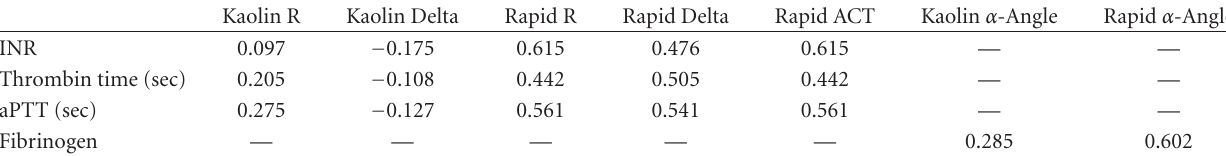
Table 4: Correlation of TEG Measurements versus INR, TT, and aPTT.